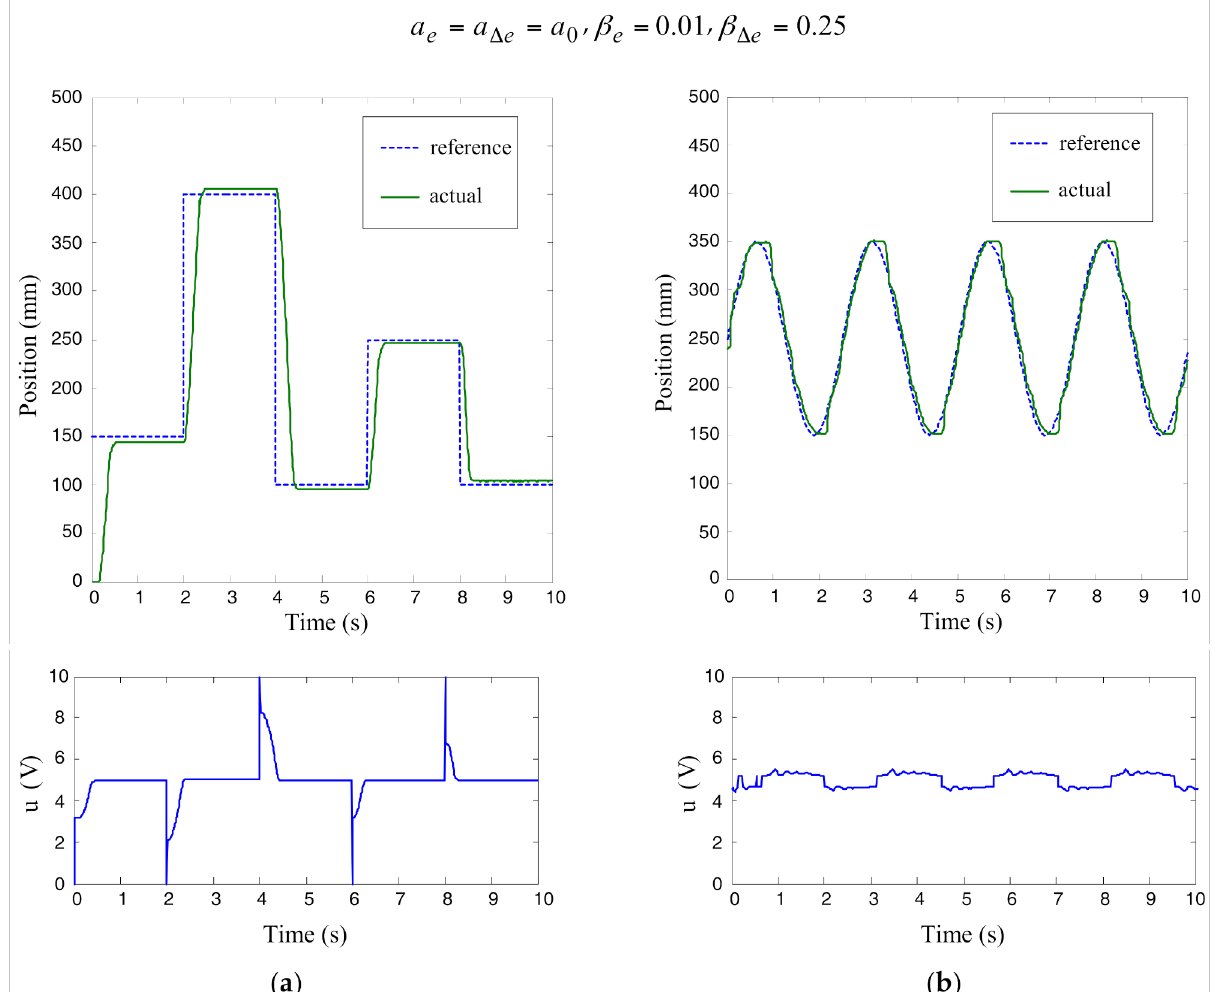
Figure 8. Experimental results for position control with two input variables e and ∆ e : ( a ) step inputs, ( b ) sinusoidal